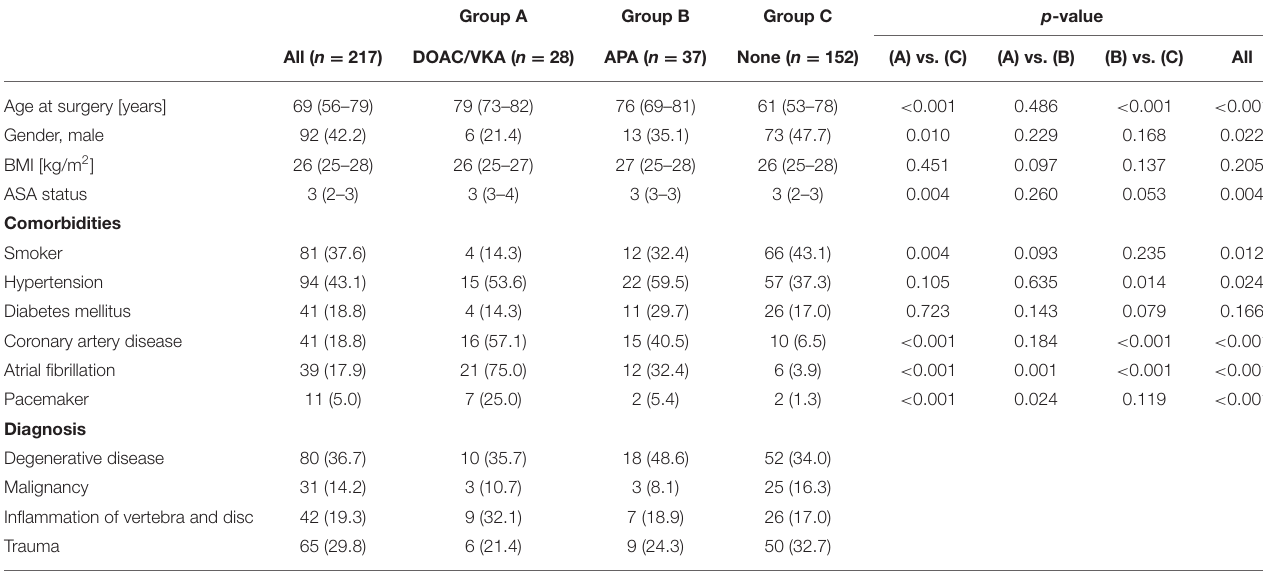
TABLE 1 | Univariable analysis of characteristics, comorbidities, and diagnoses.